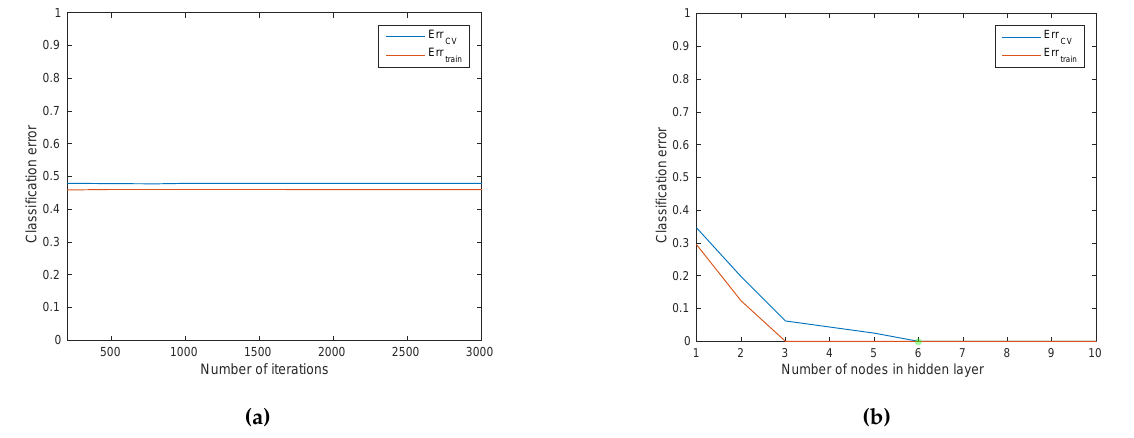
Figure 14. Tuning the performance of neural networks: solving the convergence problem. ( a ) Learning curves, α = 0.3, HLsigmoid = 2; ( b ) Model selection, α = 0.1, 500